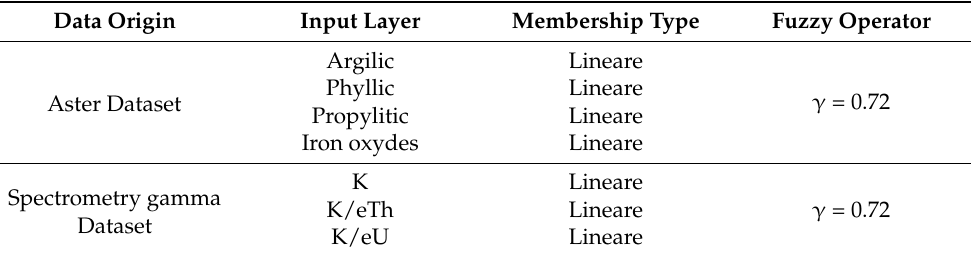
Table 4. Fuzzy membership parameters used for input